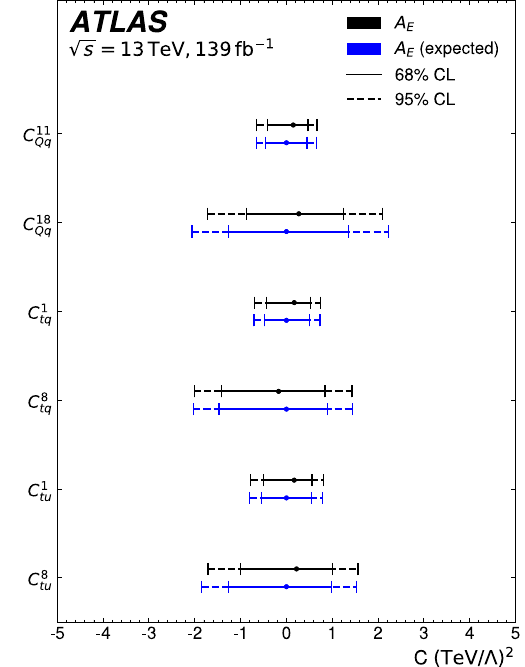
Fig. 9 Bounds on individual Wilson coefficients from the energy asymmetry, obtained from a combined fit to the measured (black) and expected (blue) energy asymmetry in all three θ j bins. The bounds on C ( TeV /(cid:17)) 2 are reported at the 68% CL (solid) and 95% CL